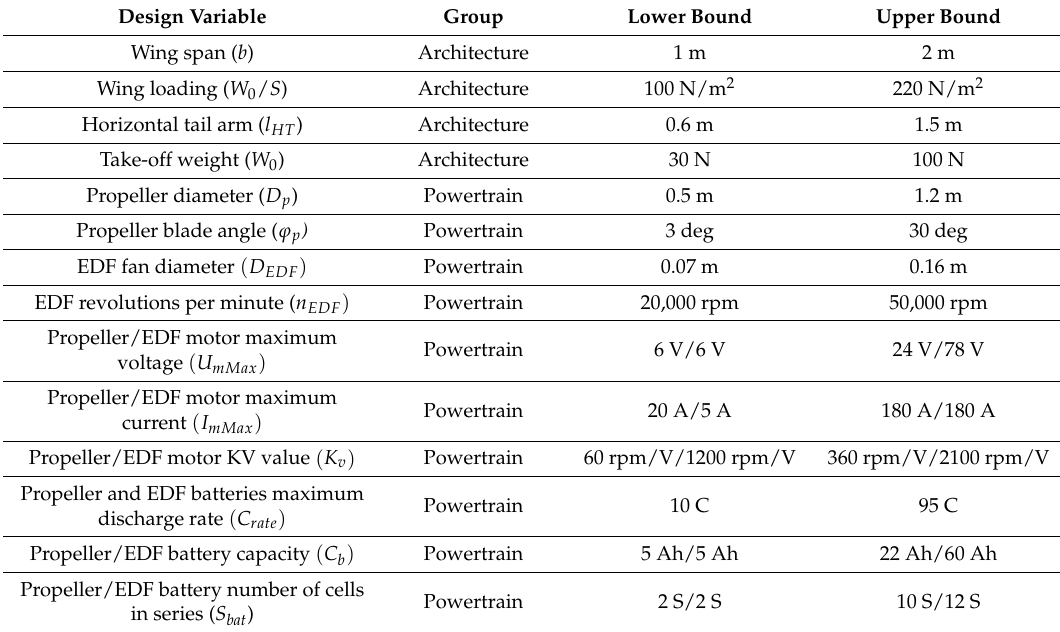
Table 2. Design variable bounds for the